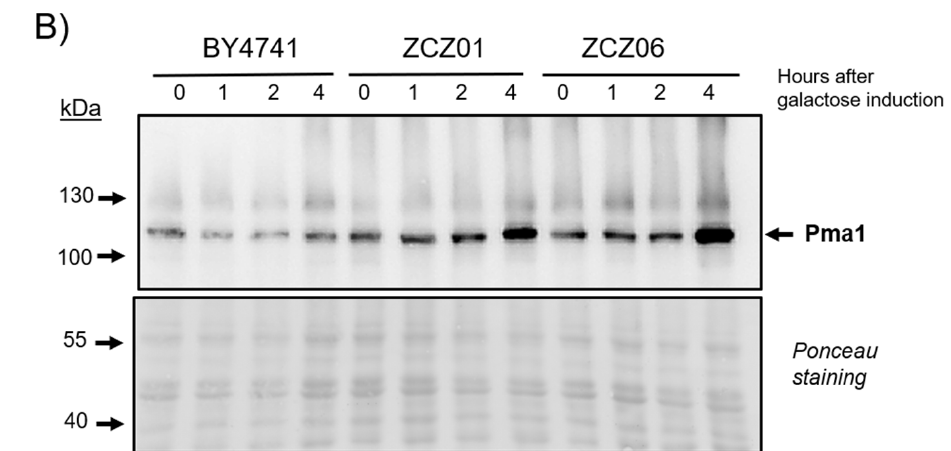
Figure 6. Overexpression of Ppz1 impairs the capacity for acidification of the medium. ( A ) Cultures of the indicated strains were prepared as described in Materials and Methods and supplemented with 2% galactose. Samples (20 mL, OD 600 = 0.6) were taken at the indicated times, pH raised to 8.0 by the addition of KOH, and changes in pH were monitored for 30 min to calculate the acidification slope (nmols H + /min). The acidification capacity at t = 0 of the different strains was: BY4741, 0.231 ± 0.030; ZCZ01, 0.190 ± 0.025; and ZCZ06, 0.339 ± 0.009 nM H + /min). For plotting, data were adjusted to t = 0 and represent the mean ± SEM from at least 5 independent experiments. *, p < 0.05; **, p < 0.01; ***, p < 0.001 with respect to the BY4741 (WT) strain. ( B ) Protein extracts from these strains